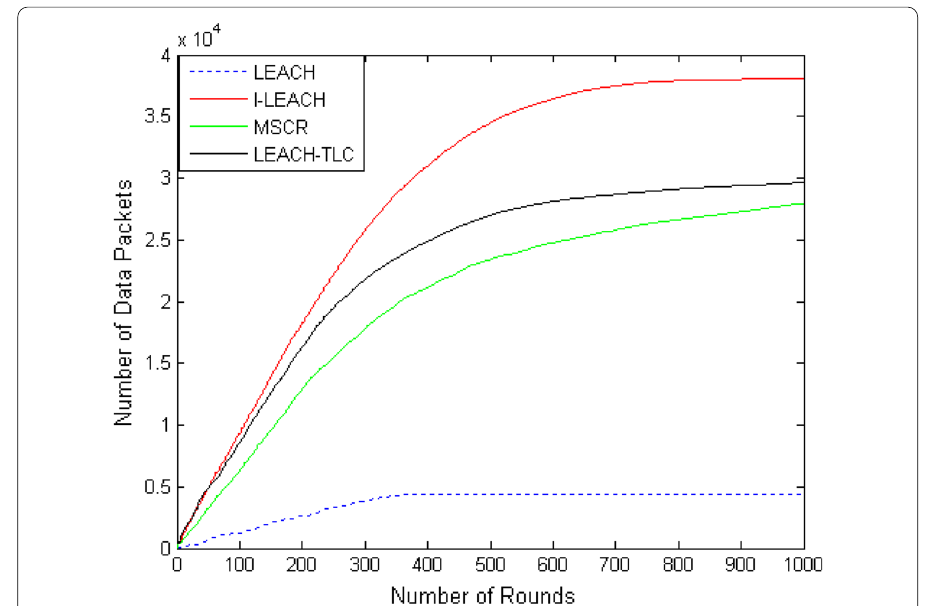
Fig. 3 Comparison of data packets